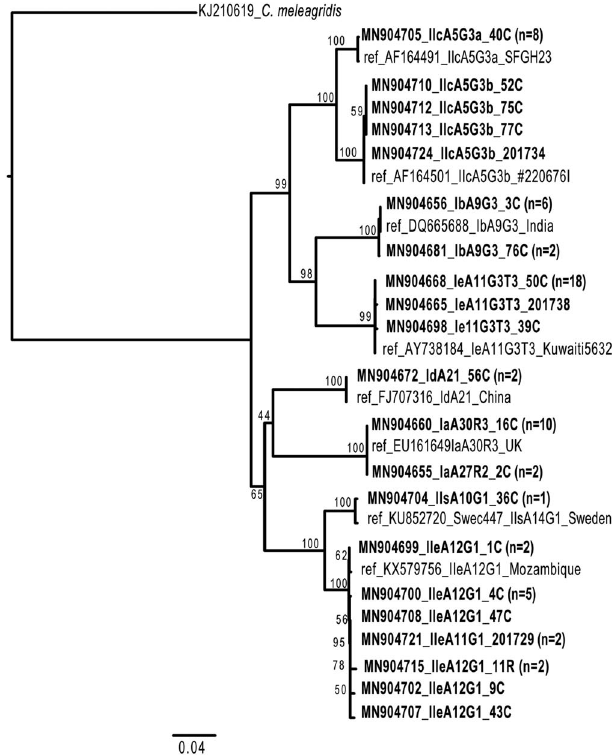
Figure 2. gp60 phylogenetic tree. Phylogeny of Cryptosporidium spp. from human patients at the University Teaching Hospital (UTH) based on the partial gp60 gene. The sequences determined in this study are indicated in bold font, and the GenBank number is shown. The representative sequence is shown if the same allele sequences were obtained, and the number of isolates is shown in parentheses. The neighbour-joining tree was constructed with 589 sites of the gp60 gene using the Kimura-2 parameter. Bootstrap values with 1000 replicates are